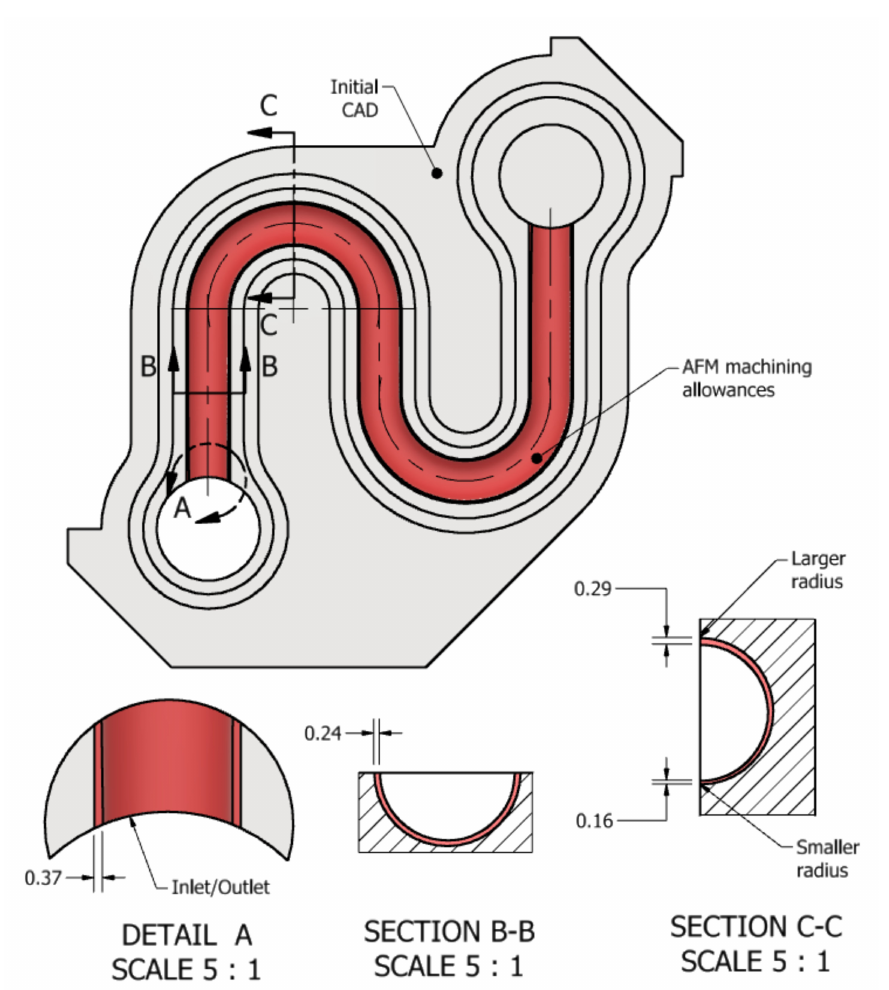
Figure A4. S-Shape, compensated 3D CAD